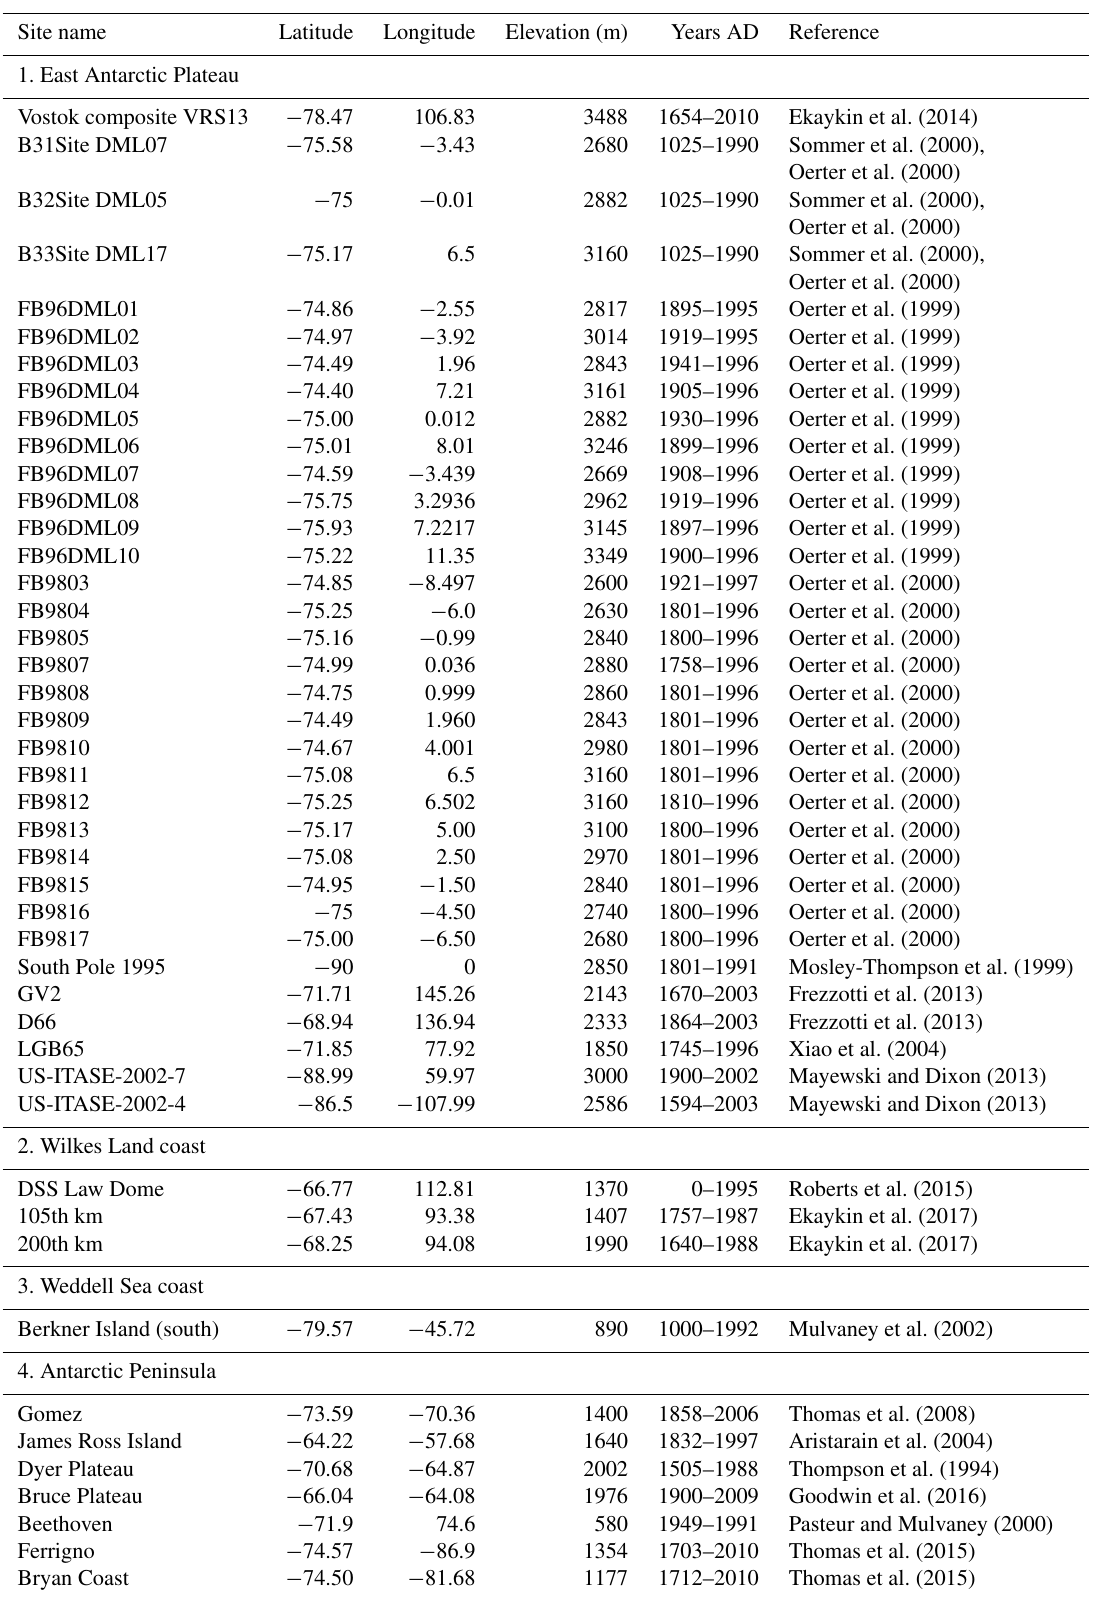
Table 1. Ice core data used in this study. Data citations can be found in Table S1 and in Thomas